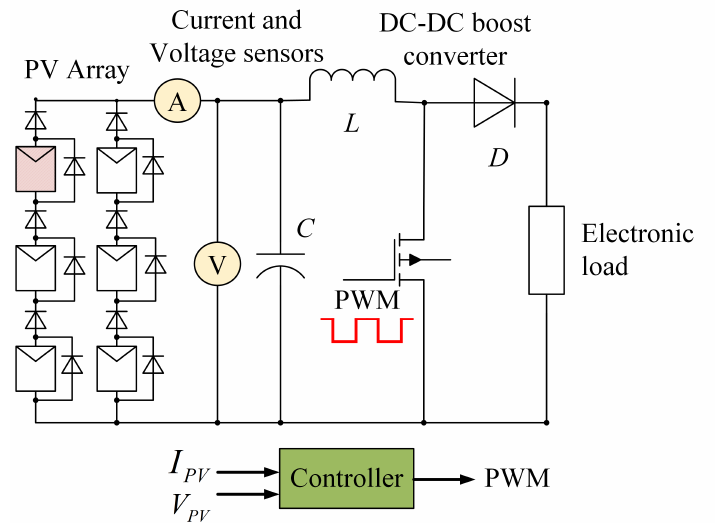
Figure 14. Simulation circuit diagram for hotspot